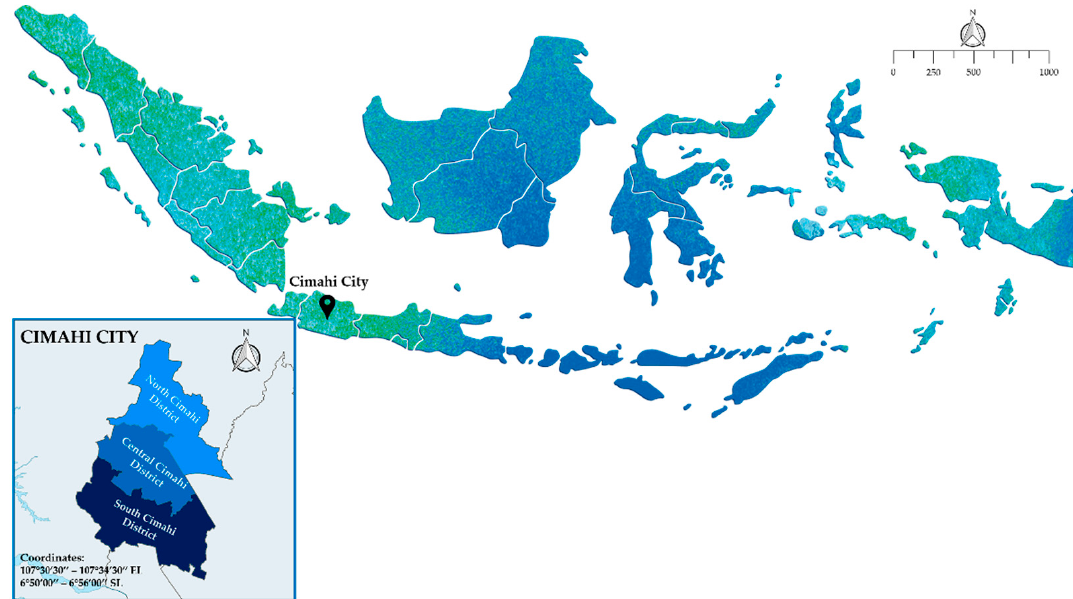
Figure 2. Cimahi City, Indonesia.